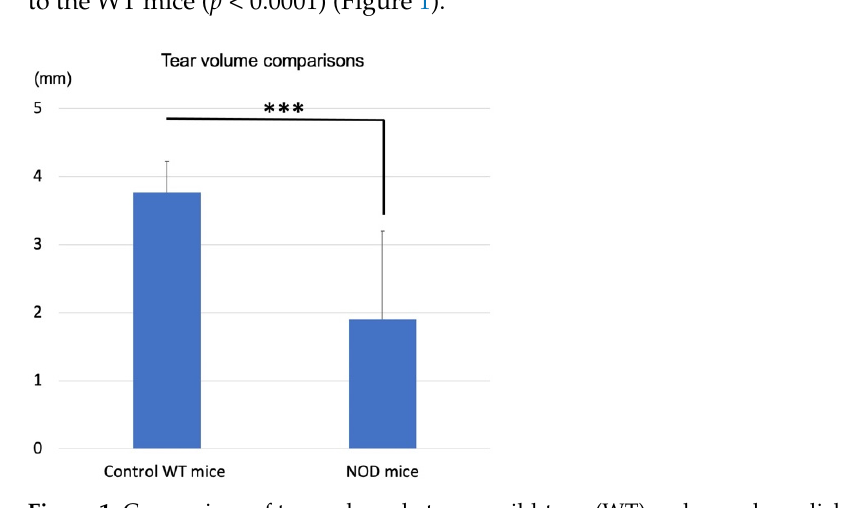
Figure 1. Comparison of tear volume between wild-type (WT) and non-obese diabetic (NOD) mice. Tear volume in the NOD mice was significantly lower than in the WT mice. *** represents p < 0.0001.